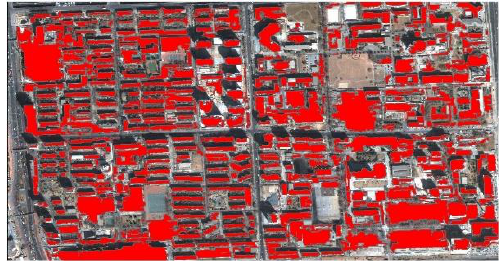
Fig. 5 The extracted buildings extraction